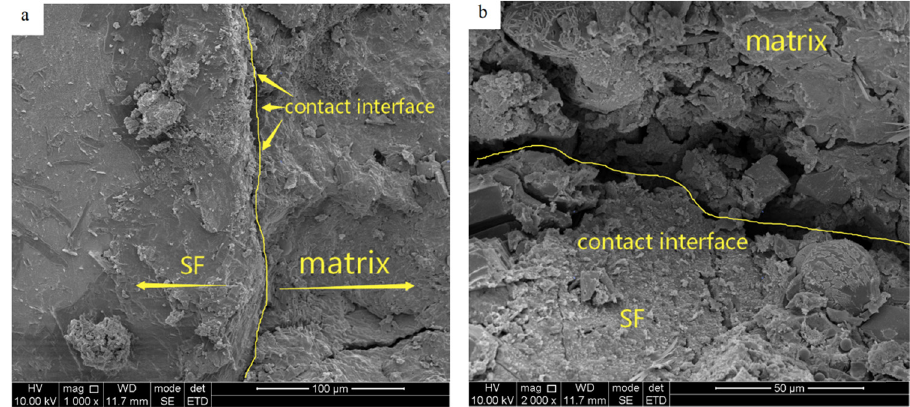
Figure 15: SFCGGPC - 0.5. ( a ) mag1000 × SF and matrix contact interface ( b ) mag2000 × SF and matrix contact interface.